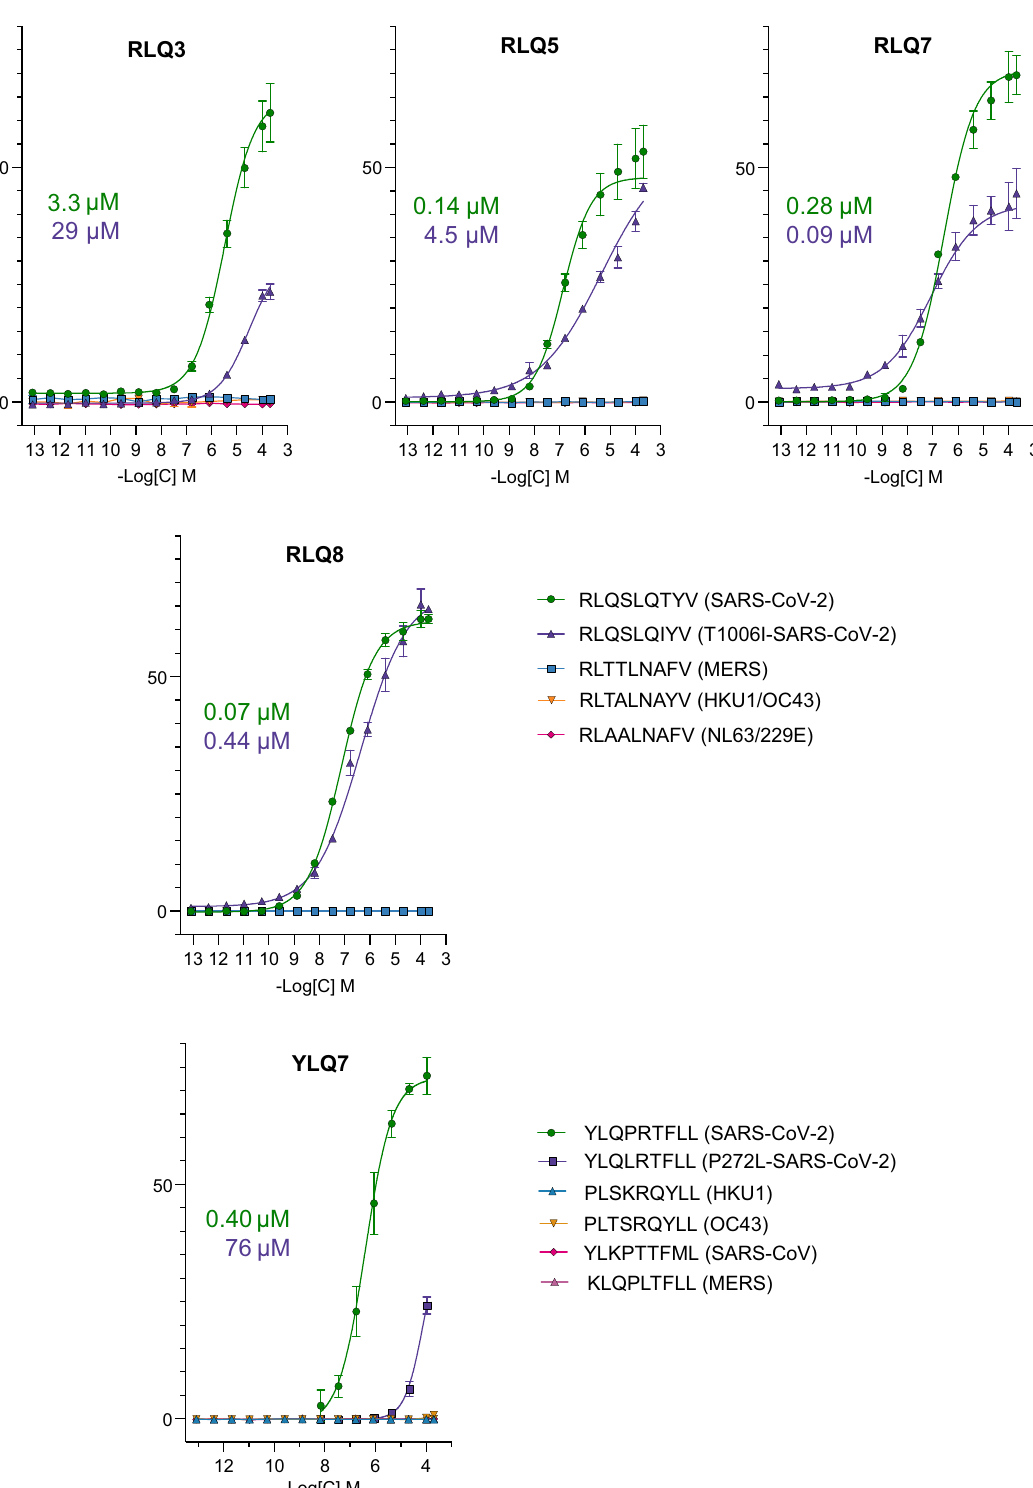
Fig. 2 T cell activation. J76 TPR cell line with transgenic TCR were co-cultivated with K562-A*02 cell line loaded with various concentrations of the cognate peptide, mutant peptide, or the homologous peptides from the endemic coronaviruses (n = 3 independent replicates). T cell activation was measured by eGFP expression regulated by the NFAT promoter. Plotted are the mean share of eGFP + cells and SD. Studied receptor is indicated above each graph. IC 50 values are shown for the cognate peptide (green) and mutant peptide